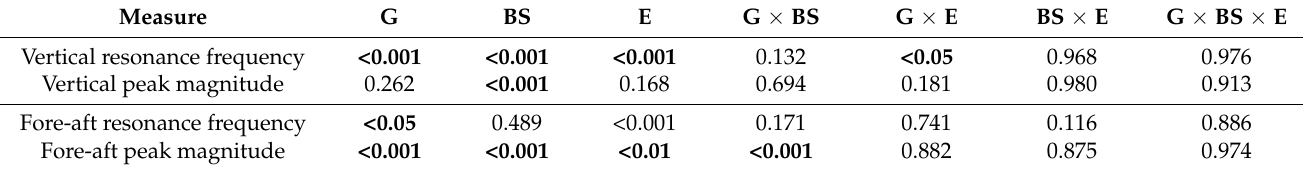
Table 4. p –values obtained from a three-factor (G, BS, and E) analysis of variance (ANOVA) of the primary resonance frequency and peak STHT magnitude responses of the male and female subjects.